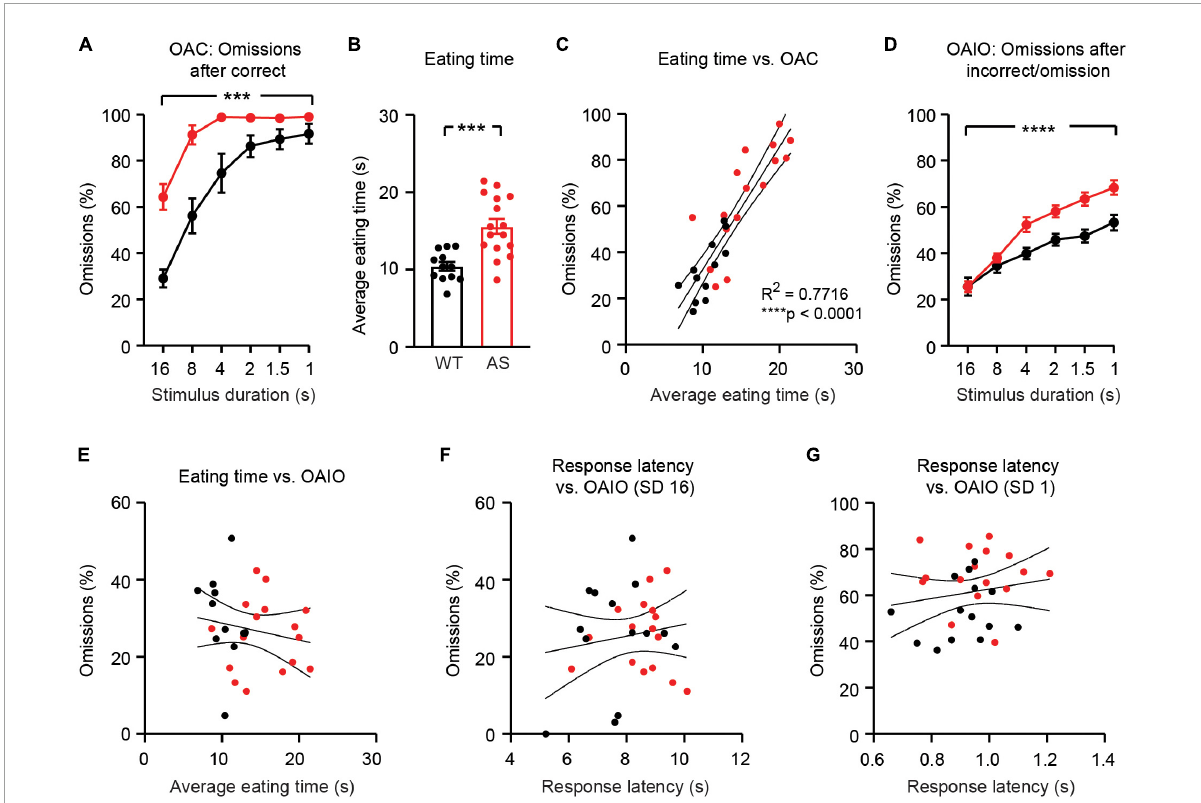
FIGURE5 Increased omissions persist in Ube3a m − / p + mice after controlling for motor confounds. WT: black, n = 14 (except n = 12 in (B) ; two videos were corrupted and not analyzed). Ube3a m − / p + (AS): red, n = 16. (A) Omissions after correct responses (OAC) are greater in Ube3a m − / p + mice. (B) Eating time is greater in Ube3a m − / p + mice. (C) Eating time is tightly correlated with OAC. (D) Omissions after non-correct trials (OAIO) are greater in Ube3a m − / p + mice at low stimulus durations. (E) Eating time is not correlated with OAIO. (F) Response latency is not correlated with OAIO during SD 16 sessions. (G) Response latency is not correlated with OAIO during SD1 sessions.